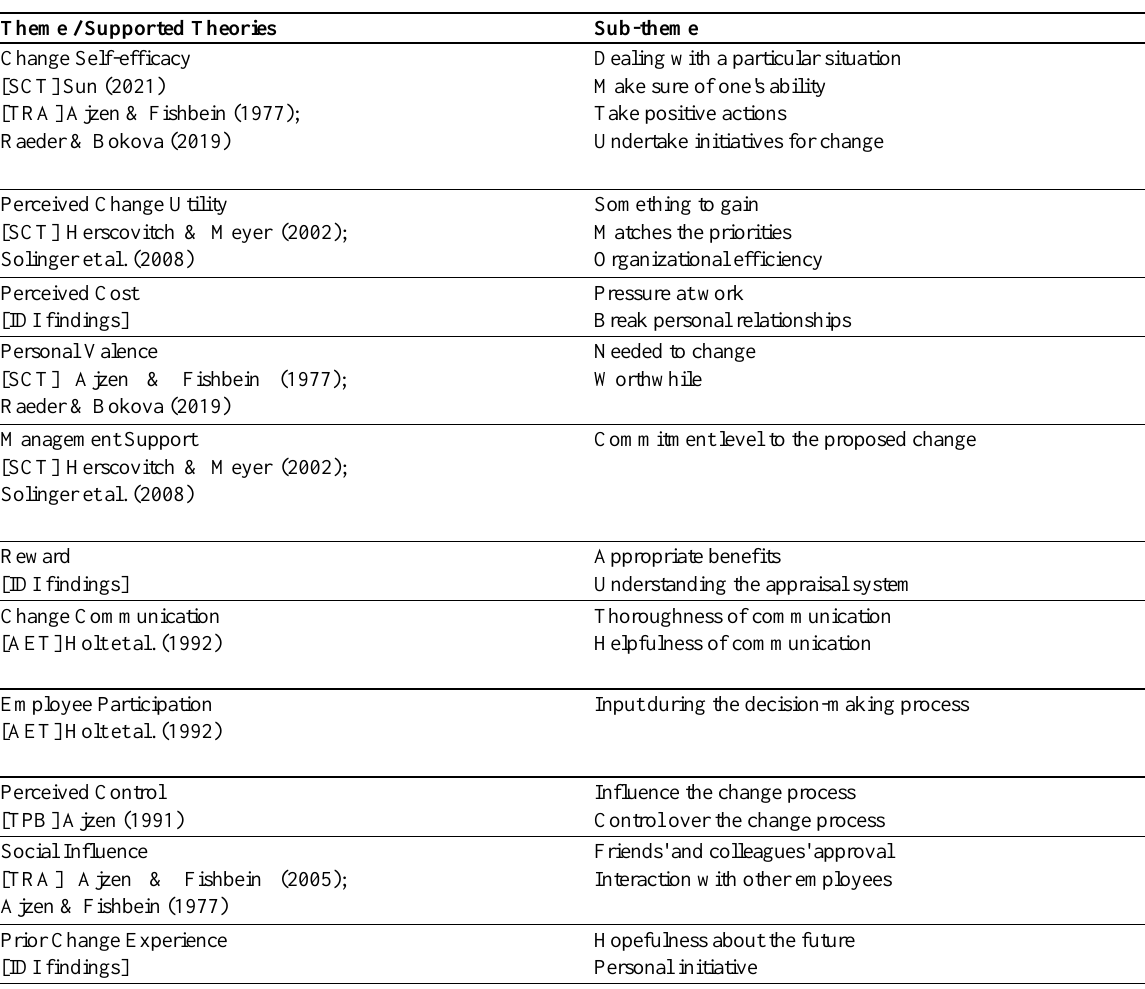
Table 2: Distribution of Themes and